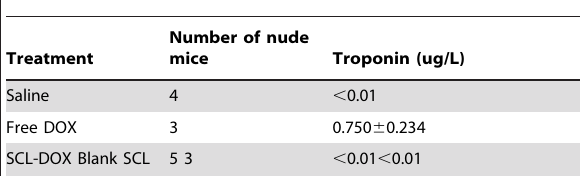
Table 3. Plasma levels of troponin.